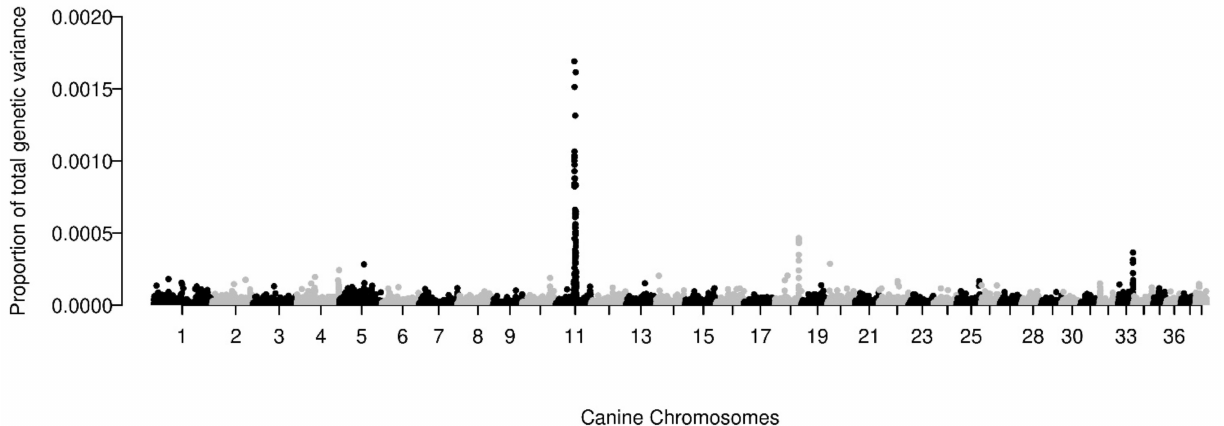
Figure 3. Posterior estimates of the total proportion of the estimated genetic variance explained by each SNP. The 38 canine autosomes are plotted on the x-axis and the estimated proportion of the total genetic variance explained is presented on the y-axis. Each dot represents a single SNP or overlapping